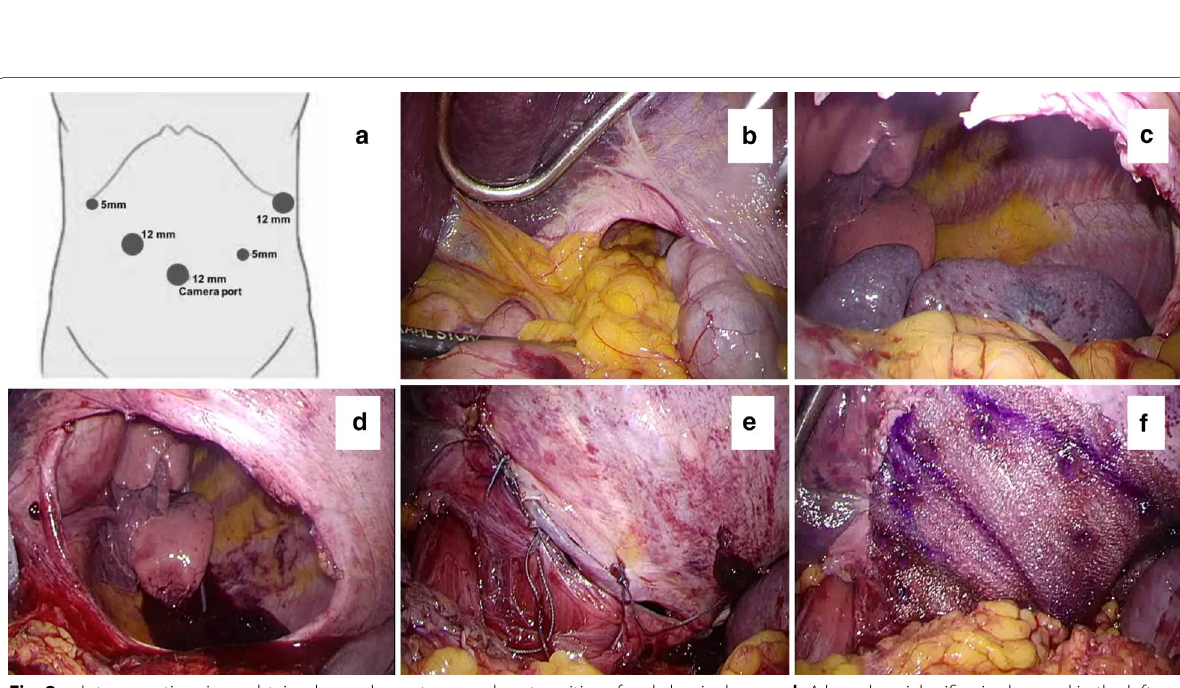
8 cm, without hernia sac. e The ×